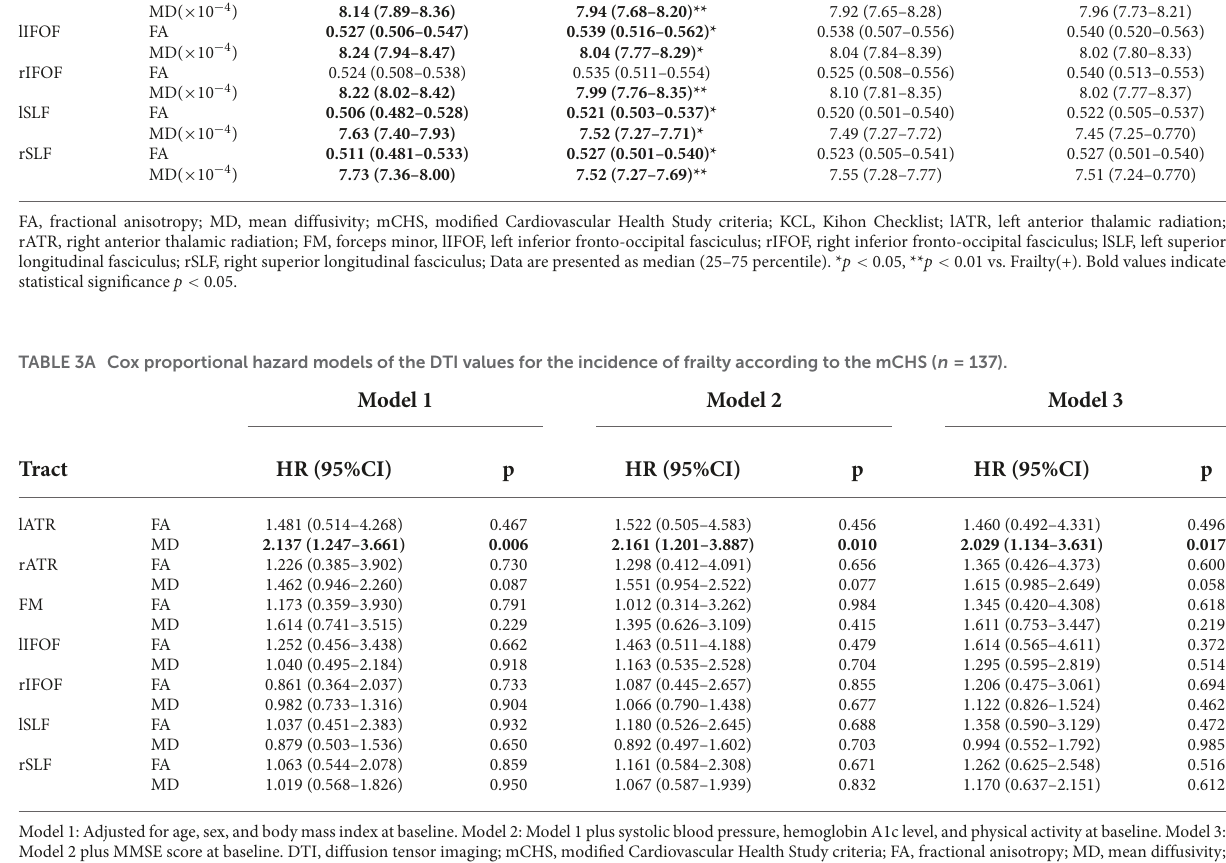
Finally, we performed Cox regression analysis by adding the history of symptomatic stroke as a confounding